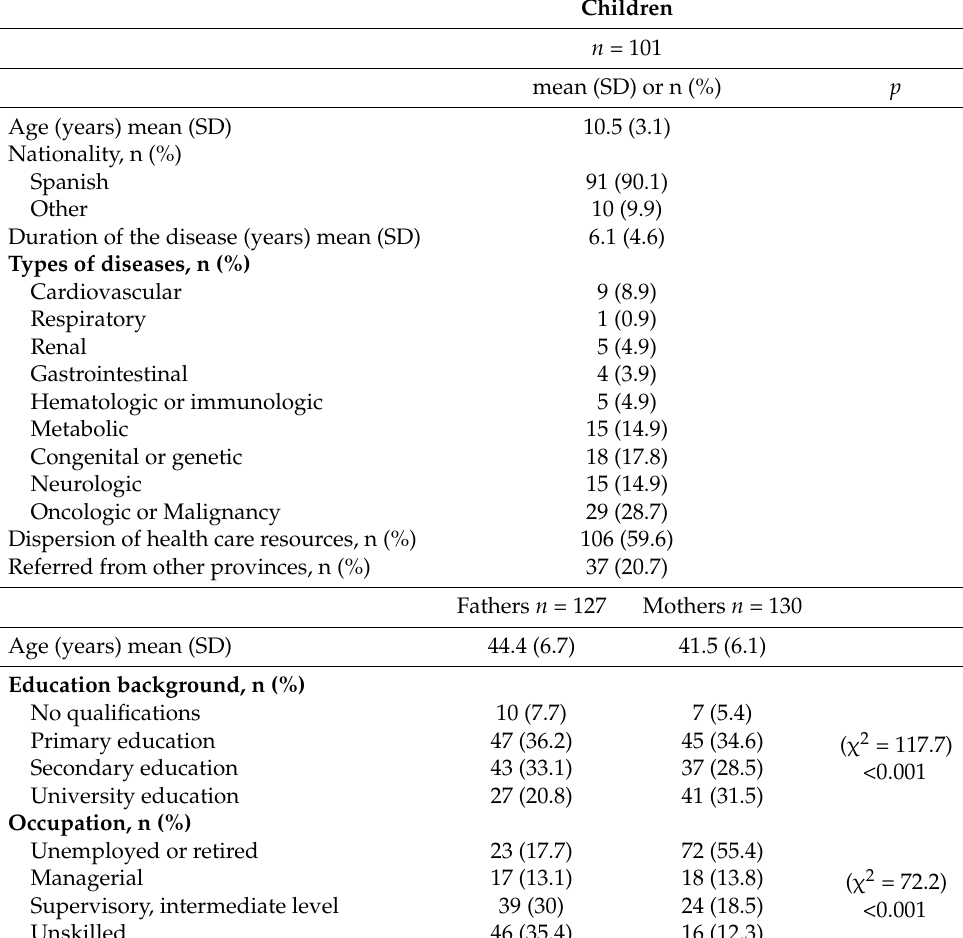
Table 1. Characteristics of the sample (children and